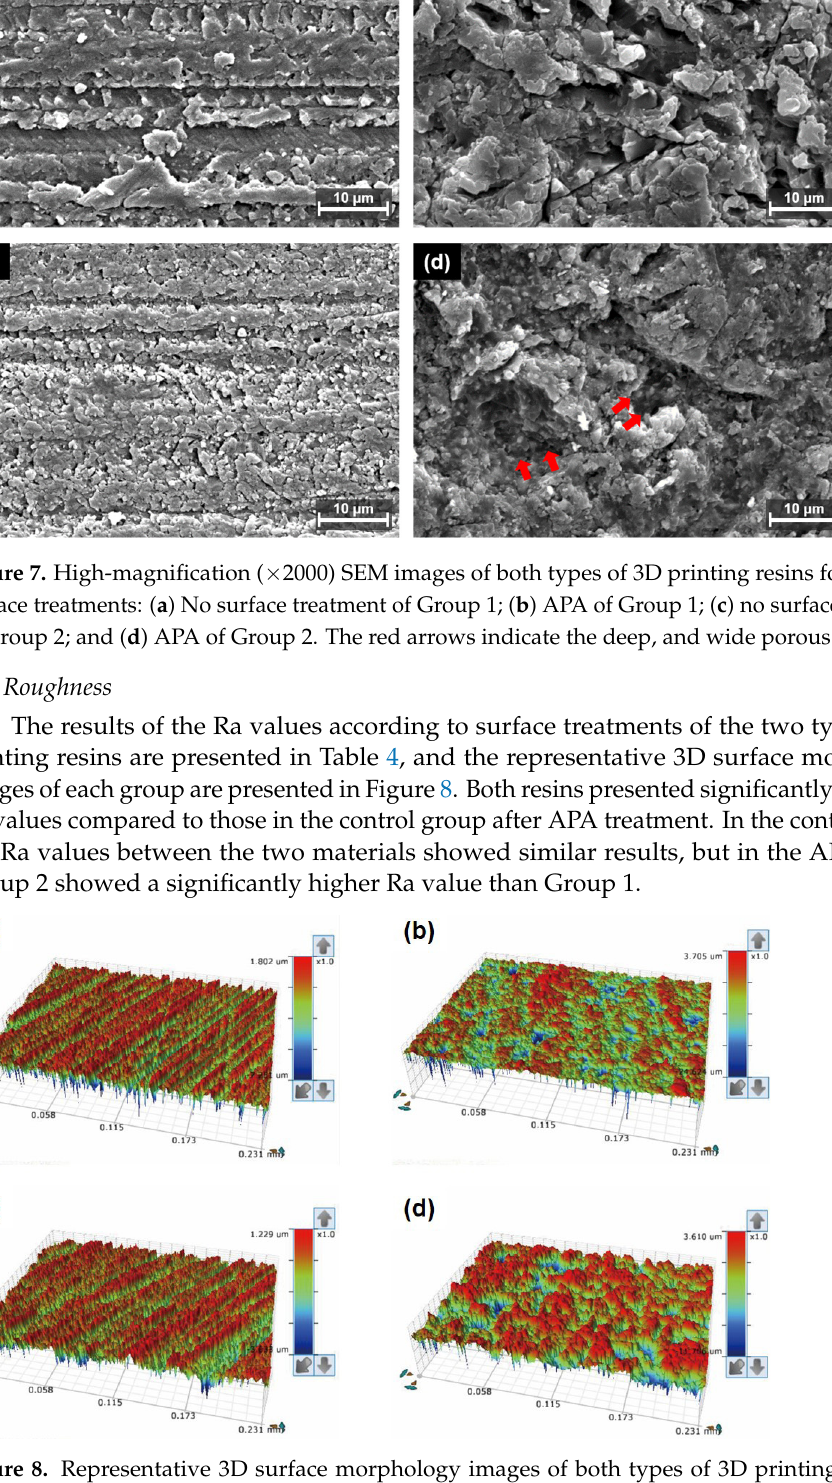
Figure 6. Low-magnification (×500) scanning electron microscopy (SEM) images of both types of 3D printing resins for different surface treatments: ( a ) No surface treatment of Group 1; ( b ) APA of Group 1; ( c ) no surface treatment of Group 2; and ( d ) APA of Group 2